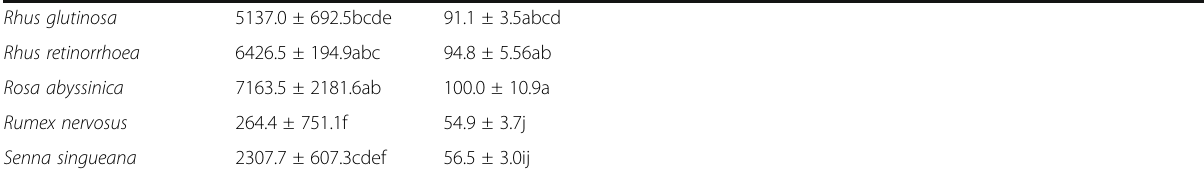
Table 7 AMF spore density (100 g − 1 dry soil) and root colonization (%) of plant species and their families (Continued)